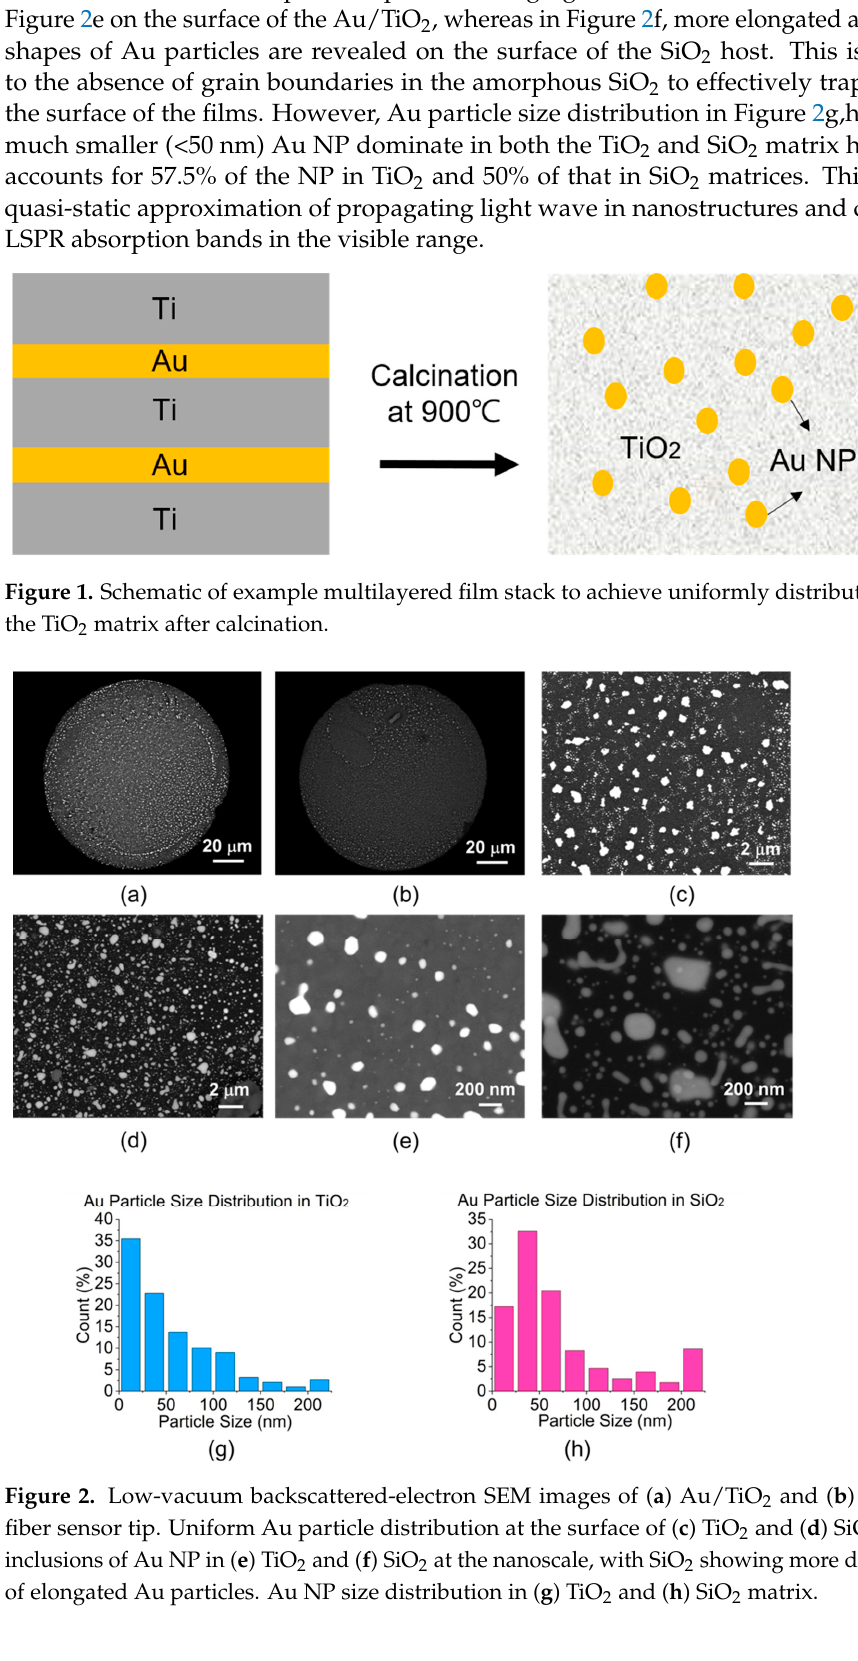
Figure 3. Spectrophotometry of ( a ) Au/TiO 2 and ( b ) Au/SiO 2 nanocomposites on planar quar tz sub- strates showing representative LSPR absorption bands in the visible range.